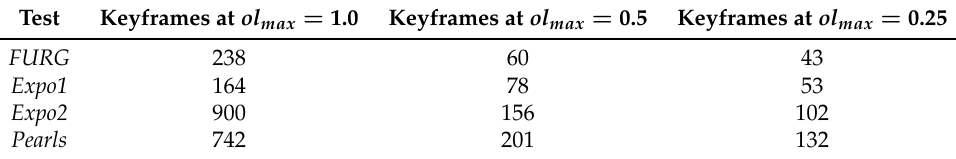
Table 3. Added images to the topological map for every test when varying ol max .